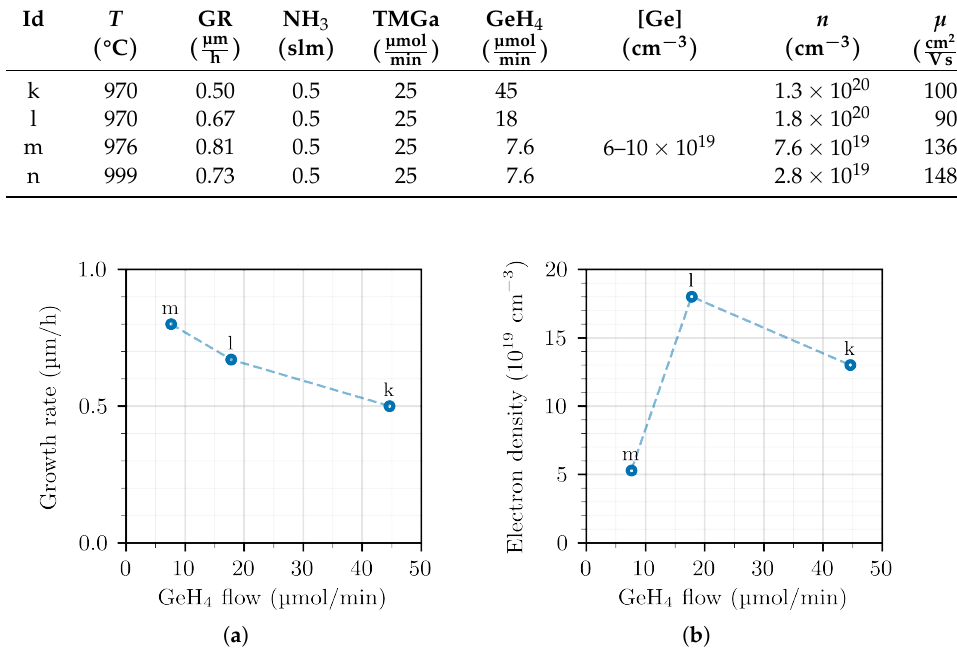
Figure 3. GR ( a ) and electrons density ( b ) for GaN:Ge layers grown at the TMGa flow of 25µmol/min, as a function of GeH 4 flow.